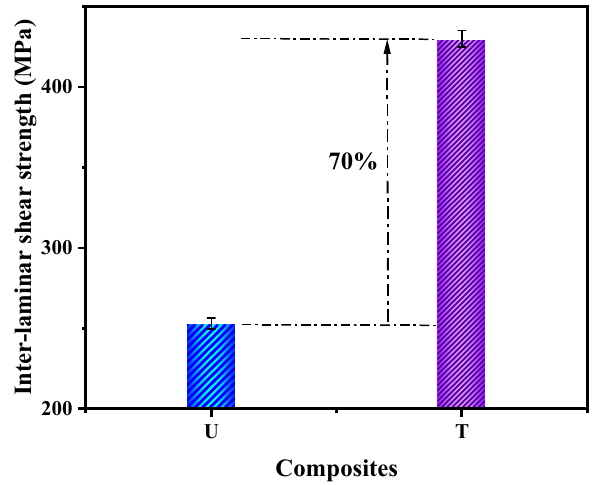
Figure 10. ILSS of composites (crosshead speed 5 mm/min, span length 26 mm).